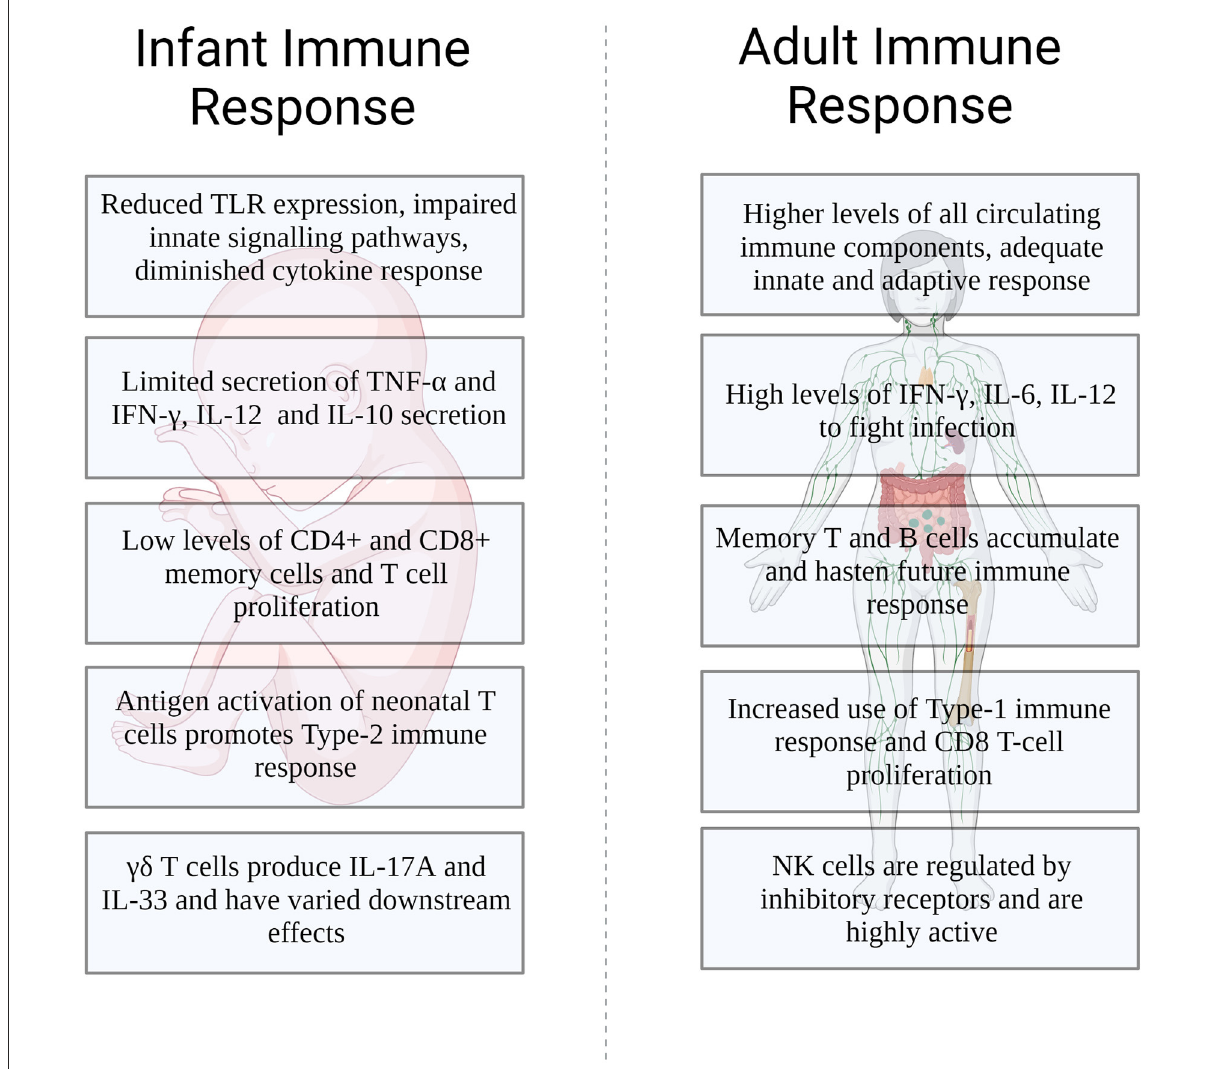
FIGURE1 Differences in the infant and adult immune response to influenza